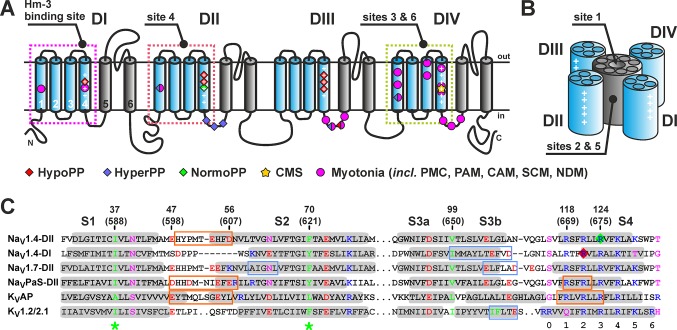

(A) Transmembrane topology of NaV channels. The S1-S4 helices are in blue and S5-S6 in gray. Conserved Arg/Lys residues are marked by the plus sign (+). Sites of the VSD mutations associated with different diseases (Simkin, 2011; Nicole and Fontaine, 2015) are marked (HypoPP, NormoPP, HyperPP, hypokalemic, normokalemic, or hyperkalemic periodic paralysis; CMS, congenital myasthenic syndrome). (B) Spatial organization of NaV channels with one pore domain and four VSDs. Approximate positions of the ligand-binding sites are shown. (C) Alignment of VSD-II and VSD-I of human NaV1.4 channel with VSDs of other NaV and KV channels. Conserved aromatic/hydrophobic, charged, and polar residues are color-coded. TM segments are highlighted in gray. The gating charge transfer center is marked by green asterisks. The sites of conserved charged residues in the S4 helix are numbered. Mutations of R222 (NaV1.4-DI) and R675 (NaV1.4-DII) (red and green diamonds) are associated with HypoPP and NormoPP, respectively. The binding sites of spider GMTs are boxed. There are two types of sites with the primary binding interface on the S3b helix (blue) and on the S1-S2 loop (orange). Sites are shown for: NaV1.4-DII/Hm-3 (present work); NaV1.4-DI/Hm-3 (Männikkö et al., 2018); NaV1.7-DII/ProTx2 (Xu et al., 2019); NaVPaS-DII/Dc1a (Shen et al., 2018); KVAP/VsTx1 (Lau et al., 2016); and KV1.2-2.1/hanatoxin (Swartz and MacKinnon, 1997). Two numbering schemes are given: residue numbers in the expressed VSD-II construct starting from the N-terminal Met1 and in the full-length NaV1.4 channel (in parentheses).